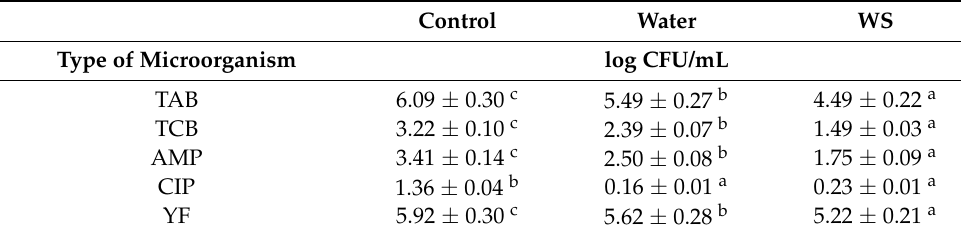
Table 6. Number of selected microorganisms in smoothie samples according to the pretreatment of raw